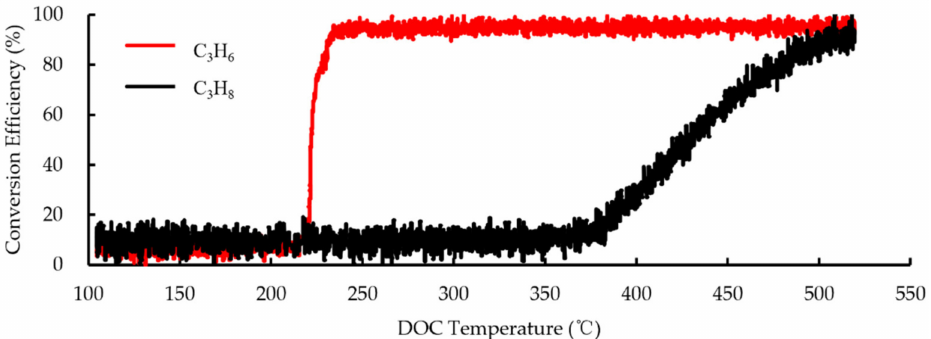
Figure 6. Hydrocarbon conversion efficiency curve in test